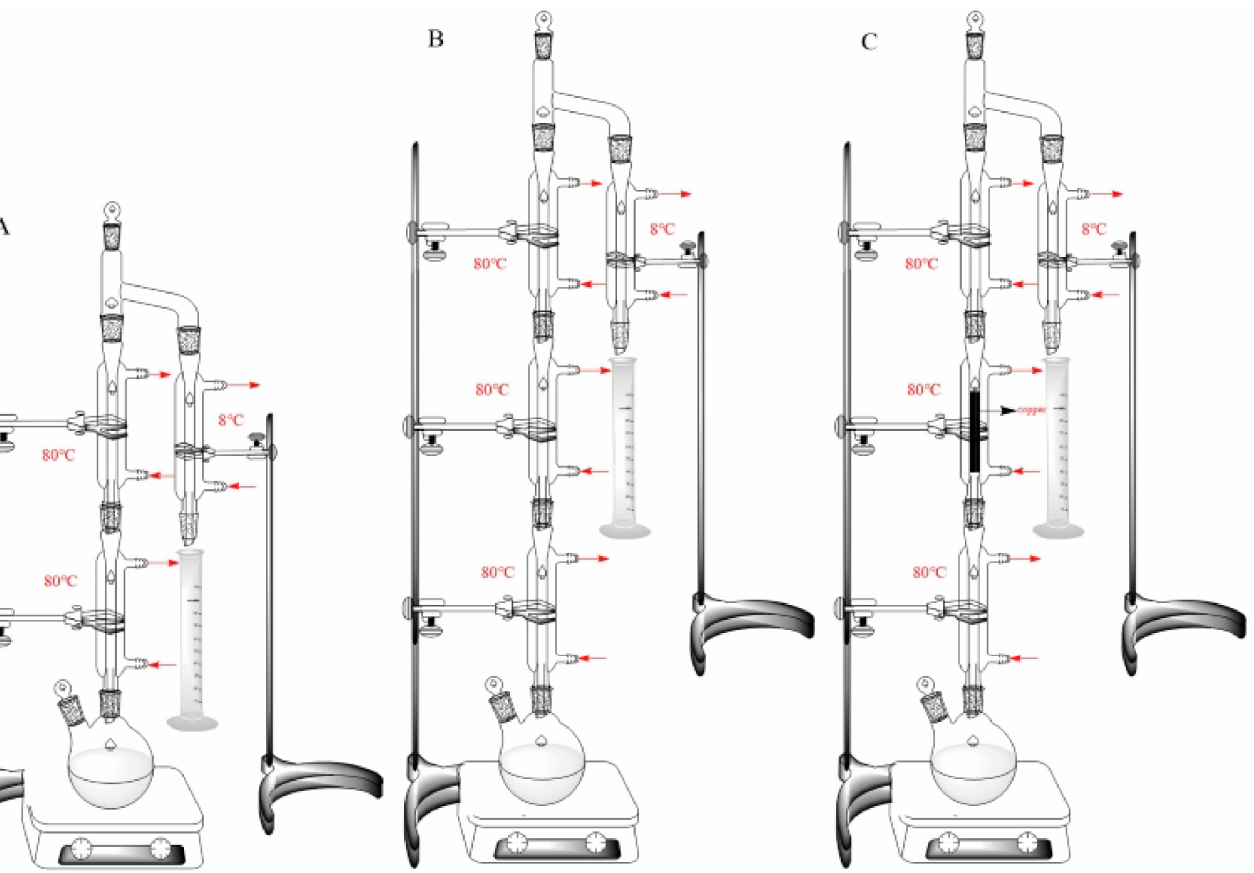
Figure 1. ( A ) The simulated device for distillation; ( B ) the optimized simulated device with an additional condenser tube for distillation; ( C ) the optimized simulated device with the addition of copper wire for distillation.